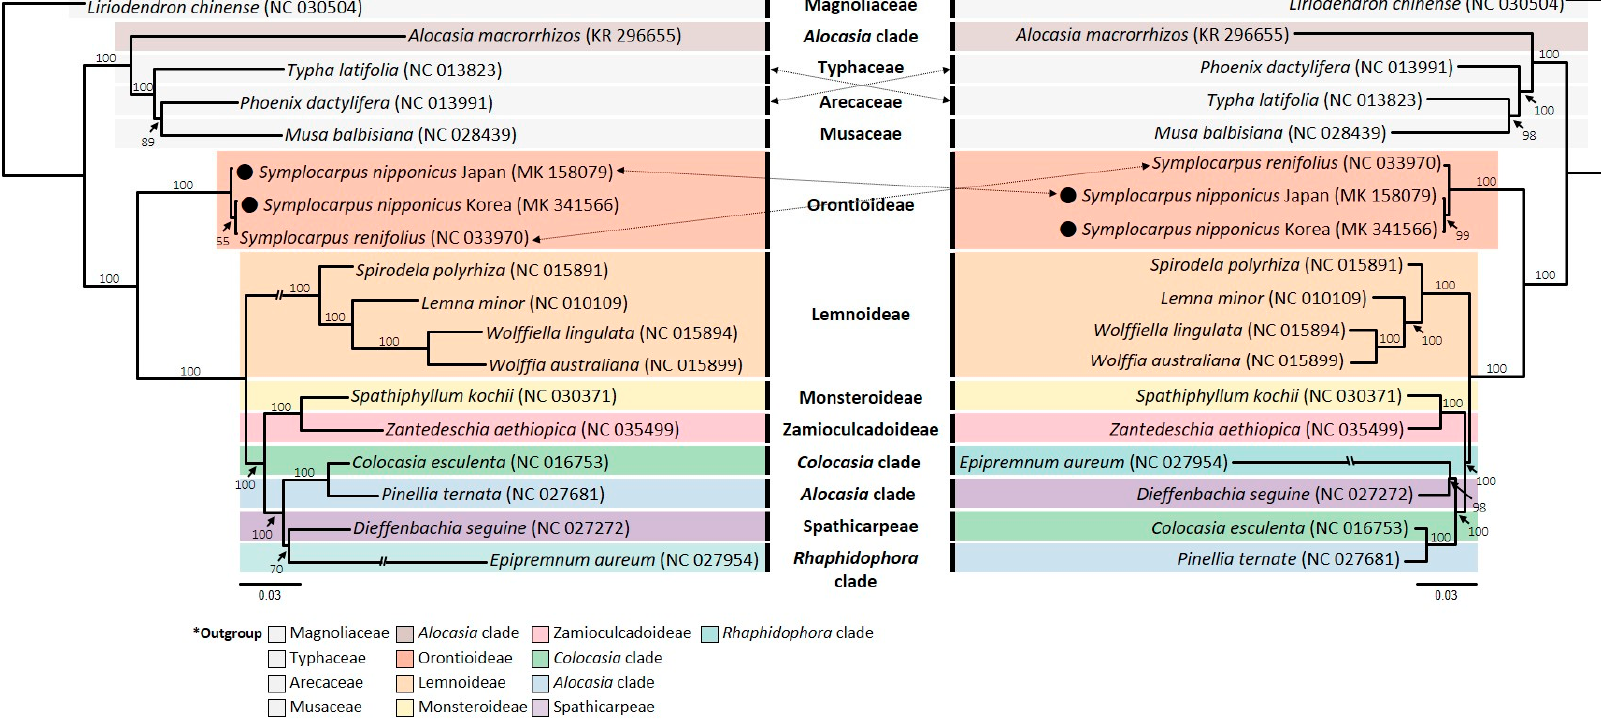
Figure 6. Phylogenetic tree reconstruction of 18 taxa using maximum likelihood based on datasets of the entire chloroplast genome sequences ( left ) and shared 85 coding genes only ( right ). ML topology was shown with ML bootstrap support (BS) value given at each node.